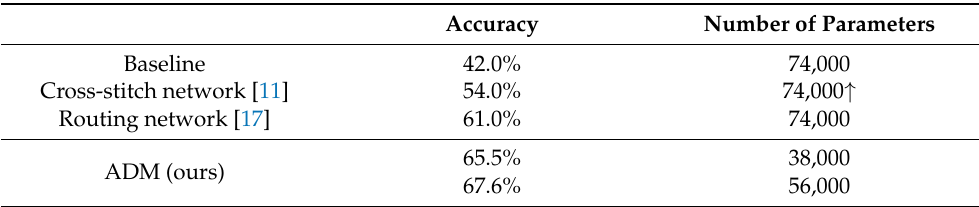
Table 3. Average classification results with the numbers of parameters of the compared methods for CIFAR-MTL (20 tasks). The accuracies of the other methods were borrowed from [17]. Accuracy